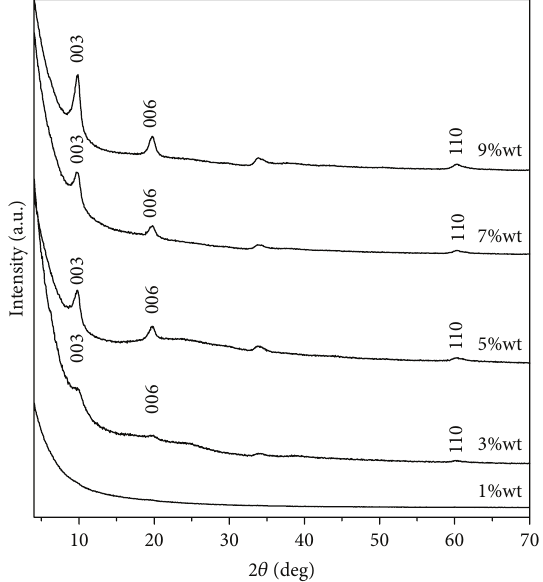
Figure 2: XRD patterns of polyvinyl chloride-Zn/Al-NO 3 at vary- ing concentrations of LDH.